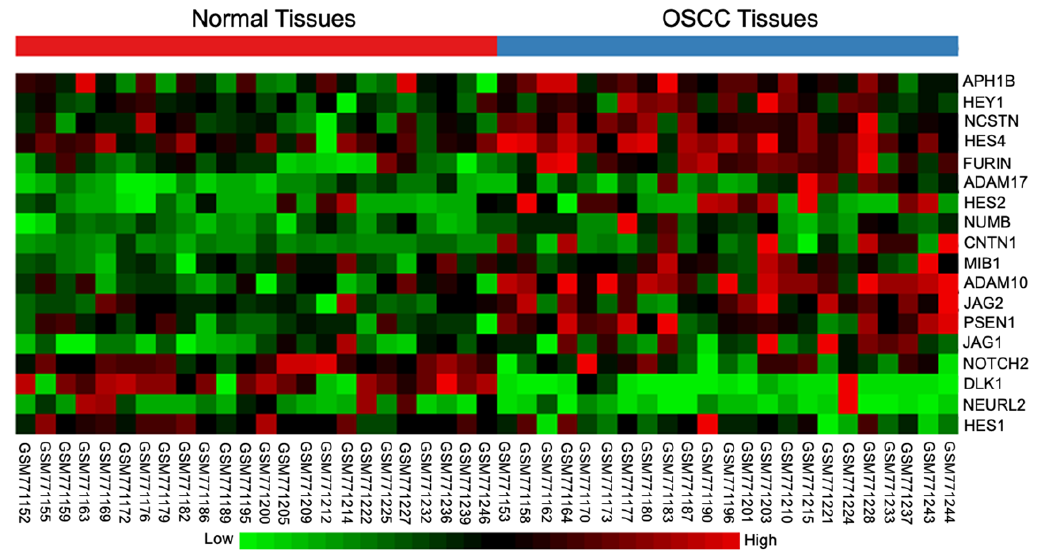
Figure 1. Notch signaling was dysregulated in oral squamous cell carcinoma (OSCC). A publicly available dataset of OSCC tissues and the normal oral tissues were downloaded and analysed using NetworkAnalyst [22]. Heatmap diagram showing the dysregulated genes related to Notch signaling in OSCC biopsy tissues, compared with normal tissues (normal tissues n = 24, OSCC tissues n = 23).